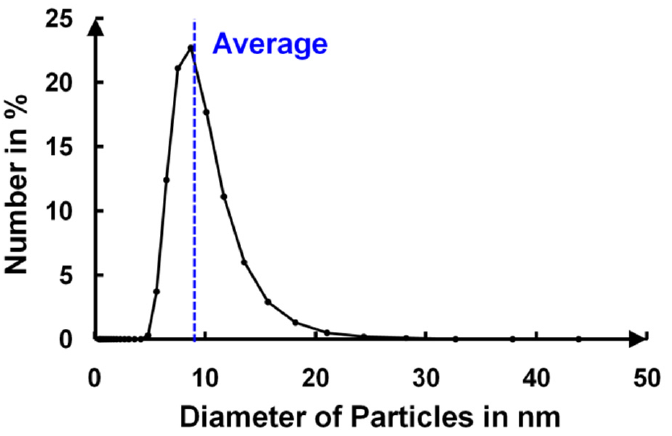
Figure 17. Size distribution of silica particles in nm. Figure 17 . Size distribution of silica particles in nm. The withdrawal speed of the dip-coating was 0.15 m · min − 1